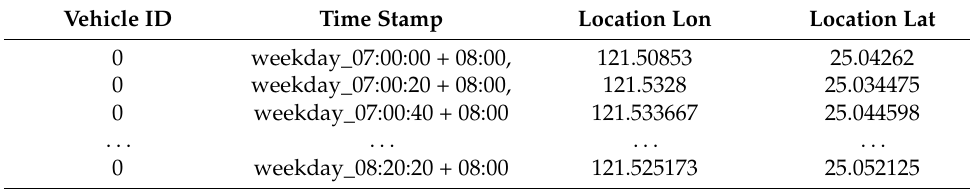
Table 3. Historical trajectories of vehicles.